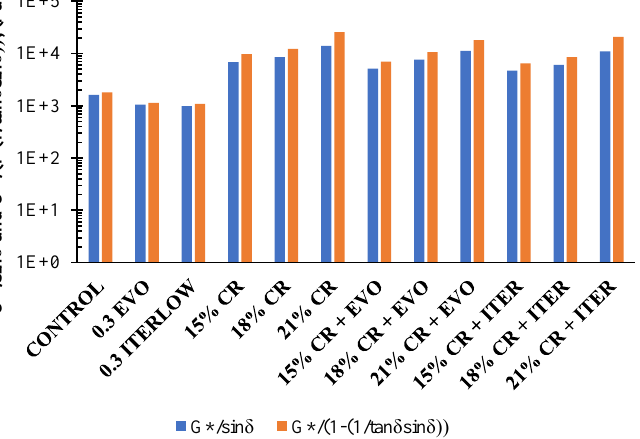
Figure 12. Comparison between the Shenoy and Superpave parameters at 64 °C in the unaged samples.